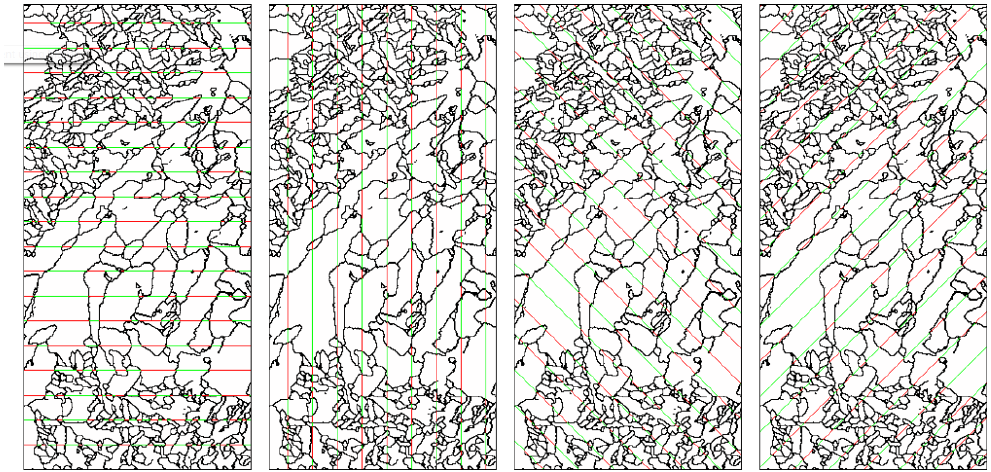
Figure 3. Measurement of average grain size in a material using the ASTM E1382 linear intercept method [20] . Reproduced with permission from Pauli Lehto, Aalto University Wiki; published by Aalto University.